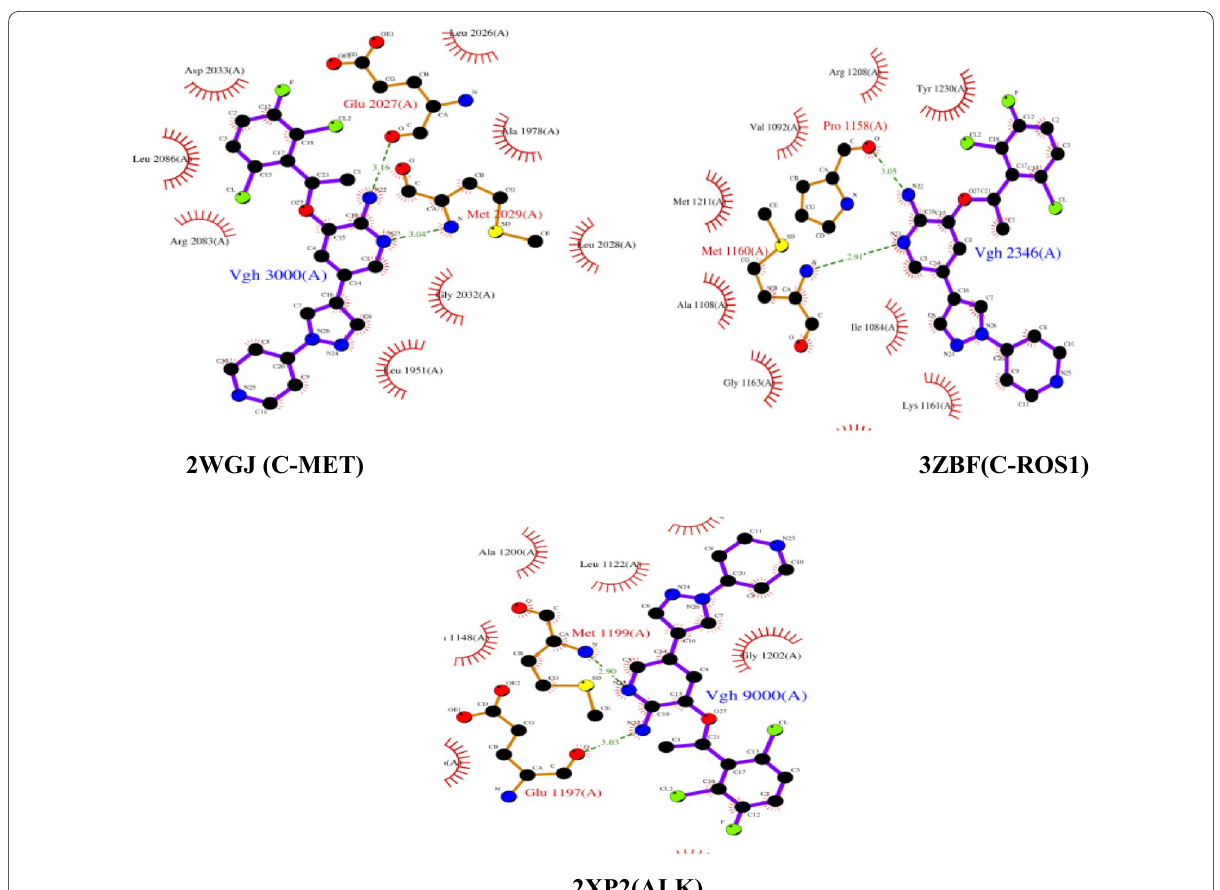
Fig. 2 Molecular interaction of Crizotinib drug with 2WGJ, 3ZBF and 2XP2. In 2WGJ, primary interaction occurs in the ATP binding sites are Glu2027, Met2029, in 3ZBF, found in Pro1158, Met 11,600 and 2XP2 protein, Glu1197, Met1199 amino acid residues. These hydrogen bond interactions are displayed as green color in the